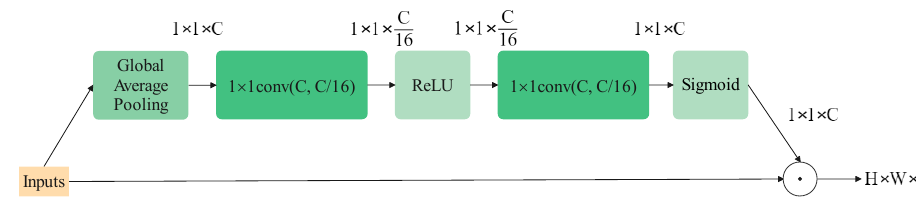
Figure 4. The structure of an SEBlock.